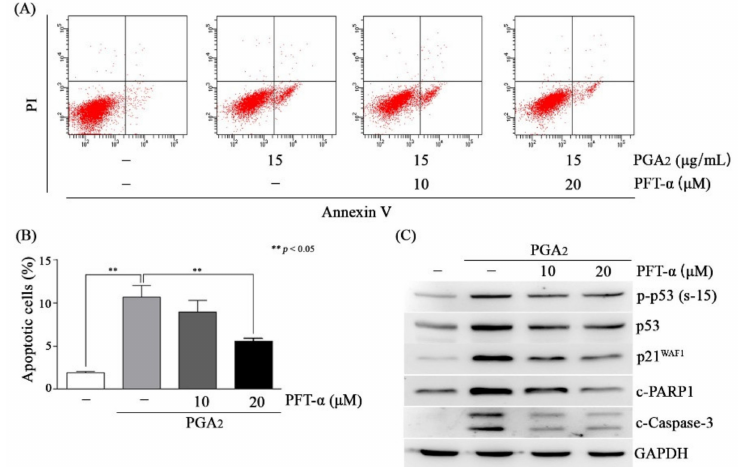
Figure 3. The e ff ect of pifithrin- α (PFT- α ) on PGA 2 -induced apoptosis in HCT116 cells. ( A , B ) HCT116 cells treated with indicated concentrations of PFT- α for 1 h were incubated in the absence or presence of PGA 2 (15 µ g / mL) for another 18 h. Cells were then subjected to annexin V assay. The representative images and statistical analysis of three independent experiments were shown in ( A ) and ( B ), respectively. The result of three independent annexin V assay was presented as mean ± SEM. ( C ) Whole cell lysates (WCLs) were prepared and subjected to immunoblot analysis against indicated proteins using GAPDH as an internal reference